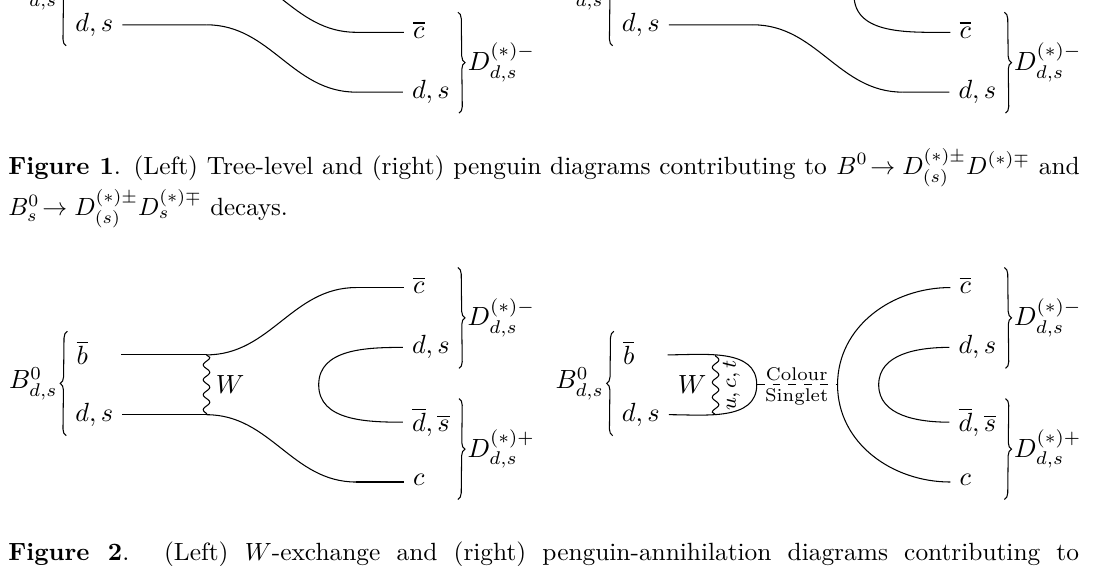
Figure 2 . (Left) W -exchange and (right) penguin-annihilation diagrams contributing to → D ( ∗ )+ B 0 D ( ∗ ) − ( s ) ( s ) ( s )